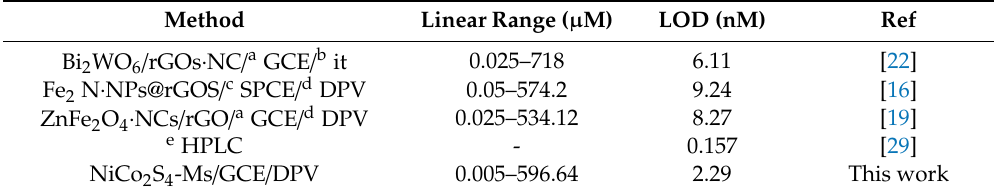
Figure 8. ( A ) DPV response of the di ff erent concentration of 4-NQO; ( B ) linear response of the reduction peak current versus concentration of 4-NQO. Table 1. Comparison of as-prepared sensor with the other previously reported 4-NQO